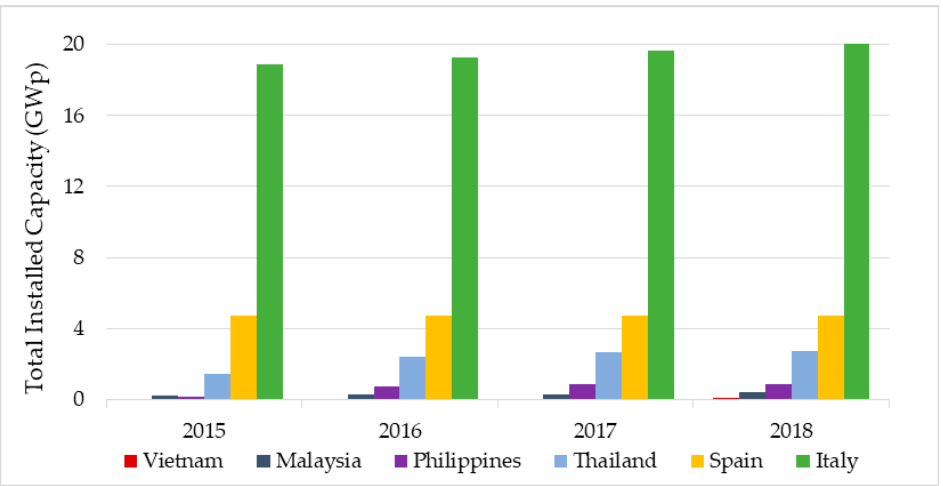
Figure 8. Total installed capacity of solar PV power in selected countries by 2018.